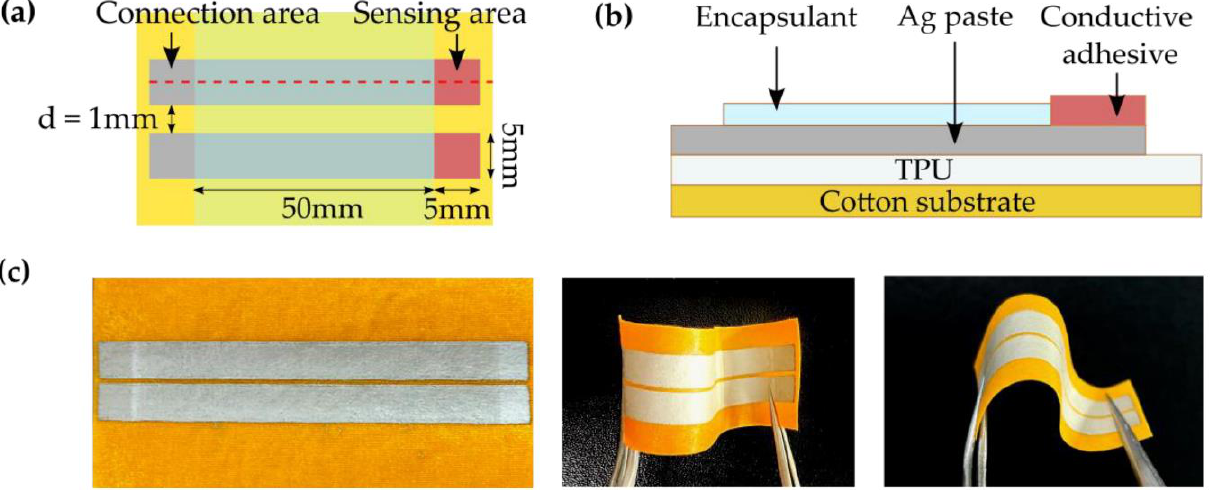
Figure 6. Images of the textile-based impedance sensor created by Jang et al. ( a , b ) present a sche- matic on the top ( a ) and side ( b ) view of the sensor, respectively, and ( c ) demonstrates its flexibility through photographs. Images reproduced with permission from [70].